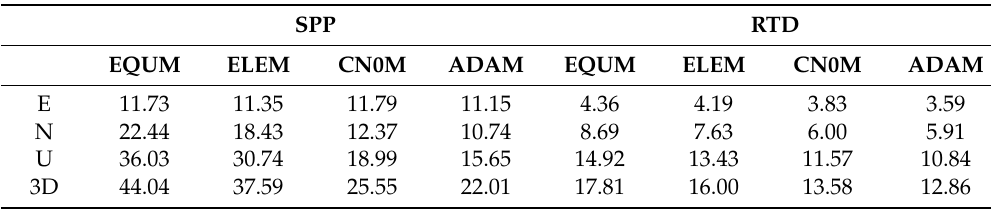
Figure 8. Positioning differences between the SPP solutions and the precise coordinates of dataset no. 1. ( a ) Results of the equal-weight model (EQUM); ( b ) results of the elevation model (ELEM); ( c ) results of the C/N0 model (CN0M); and ( d ) results of the adaptive model (ADAM). Table 1. Statistical results of SPP and RTD using the equal-weight model (EQUM), elevation model (ELEM), C/N0 model (CN0M), and adaptive model (ADAM). The RMS values of E, N, and U directions, and 3D RMS values were calculated from dataset no. 1 (m).